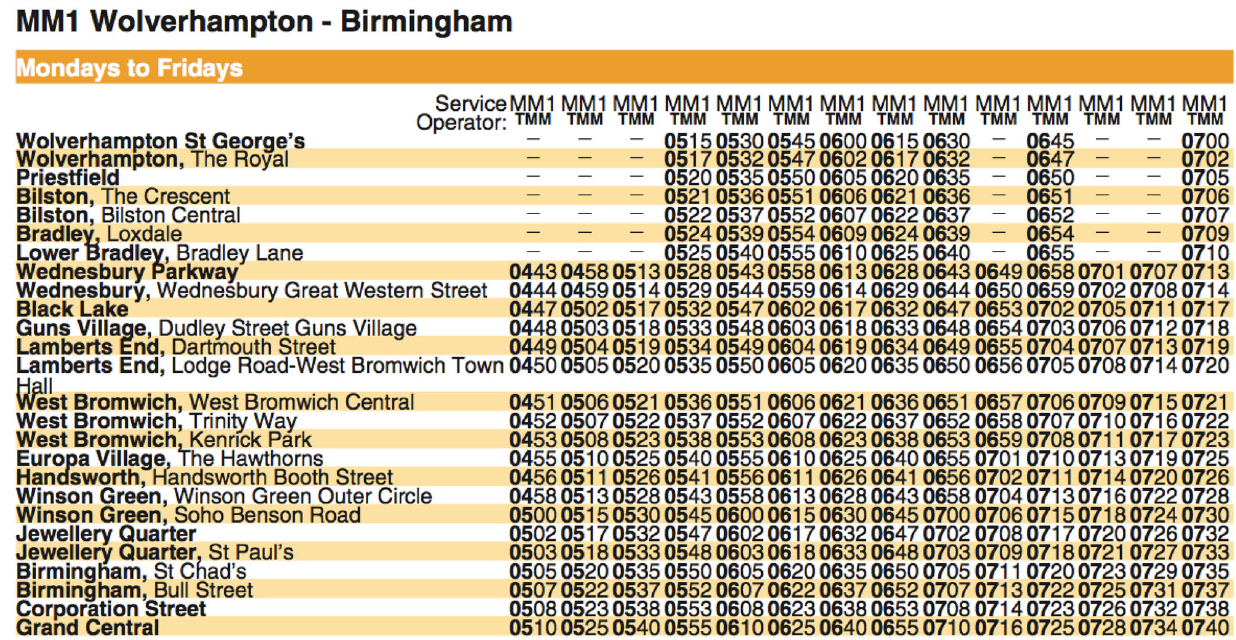
Fig. 3 Part of the timetable from Wolverhampton to Grand Central Table 1 No. of services from Wednesbury Parkway to Birmingham Grand Central (section 1) Time period No. of trains